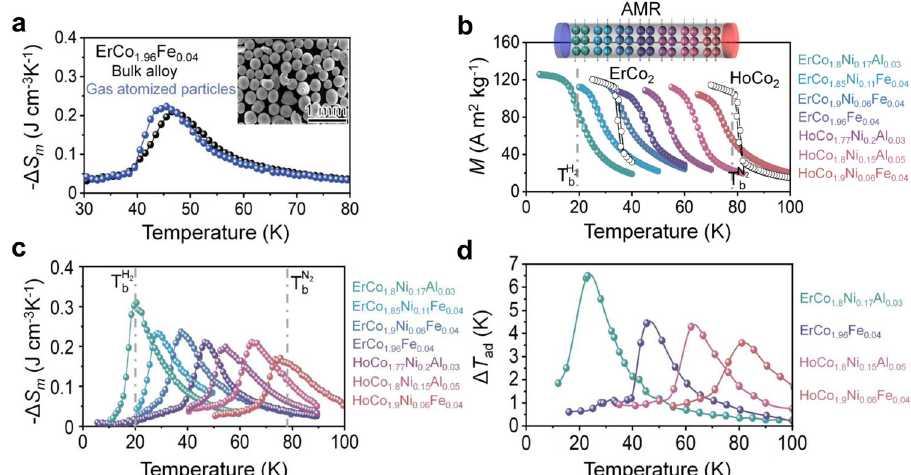
Fig. 6 Magnetocaloric effects in compositionally engineered (Ho)ErCo 2 -based alloys. a Comparison of the temperature-dependent magnetic entropy change ( − Δ S m ( T )) of a bulk sample (black) and gas-atomised (blue) ErCo 1.96 Fe 0.04 particle. The inset shows a scanning electron microscopy (SEM) image of a gas-atomised sample. b Temperature-dependent magnetisation M ( T ) measurements of the cooling and heating branches from 5 K to 100 K at 1 K intervals ( µ 0 H = 1 T ) for a series of magnetic refrigerants with tailored transition temperatures, the spherical particles in AMR with different colours correspond to different magnetic refrigerants with different transition temperatures in b . c Temperature-dependent magnetic entropy change − Δ S m ( T ) curves of magnetic refrigerants with tailored transition temperatures covering the large temperature window from 20 K to 77 K. d Adiabatic temperature change ( Δ T ad ) at the fi eld change ( Δ H ) of 5T of the selected magnetic refrigerants developed in this work at their transition temperatures. The selected colours of the curves in b – d correspond to the colour of listed alloy